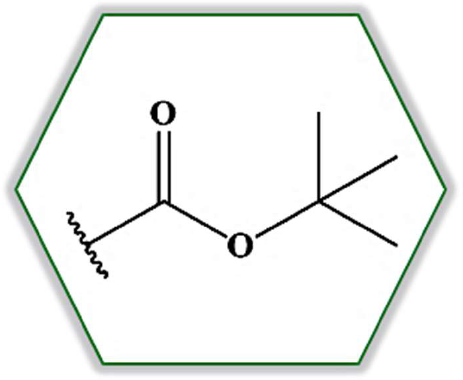
Figure 1. Chemical structure of Boc-protecting group .